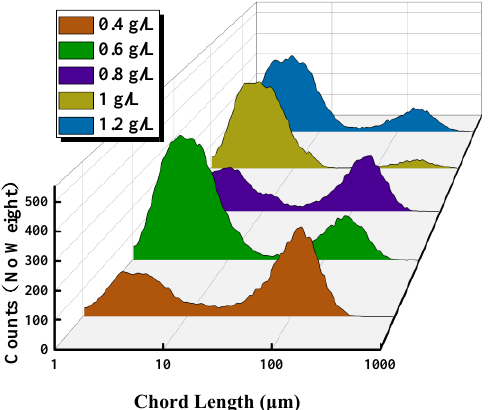
Figure 7. Weighted distribution of kaolinite suspension with different concentrations of PEO.